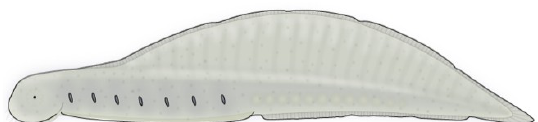
Figure 5. Yunnanozoon lividum . Animal is 6 cm in length. PaleoArt credit: Cyrus Theedishman. Used here per CC BY-SA 3.0.